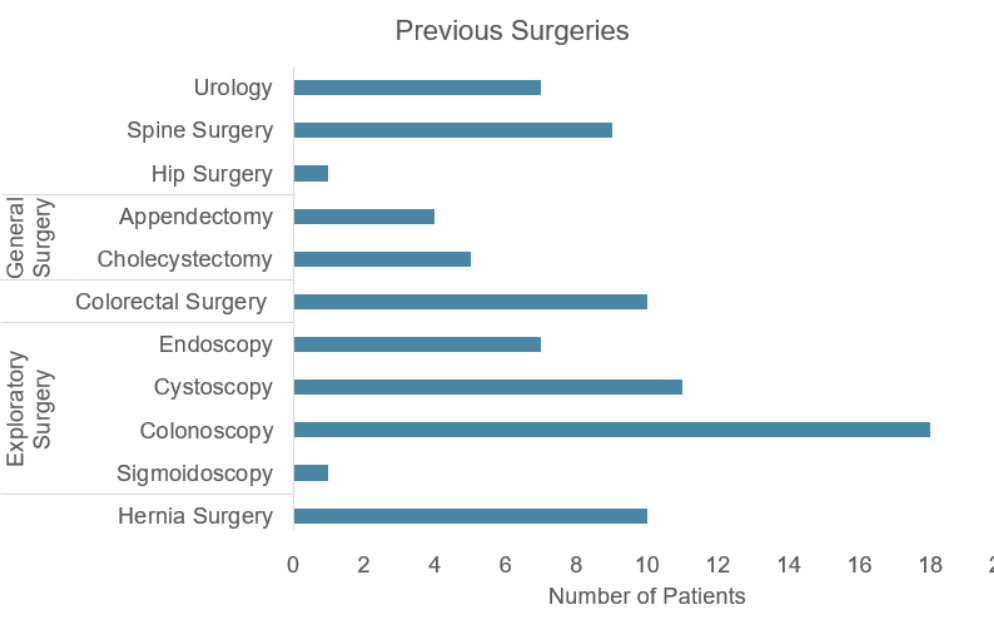
Fig. 1. Previous medications tried before presenting to Pelvic Rehabilitation Medicine for new patient consult.